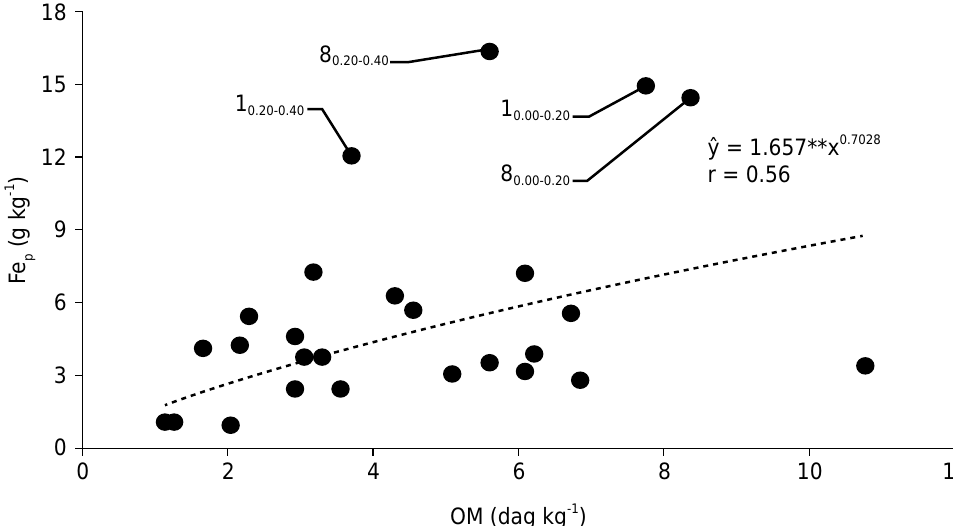
Figure 2. Ratio between concentration of Fe-pyrophosphate (Fe p ) and organic matter (OM) of the soils. ** : significant at 1 % by the F